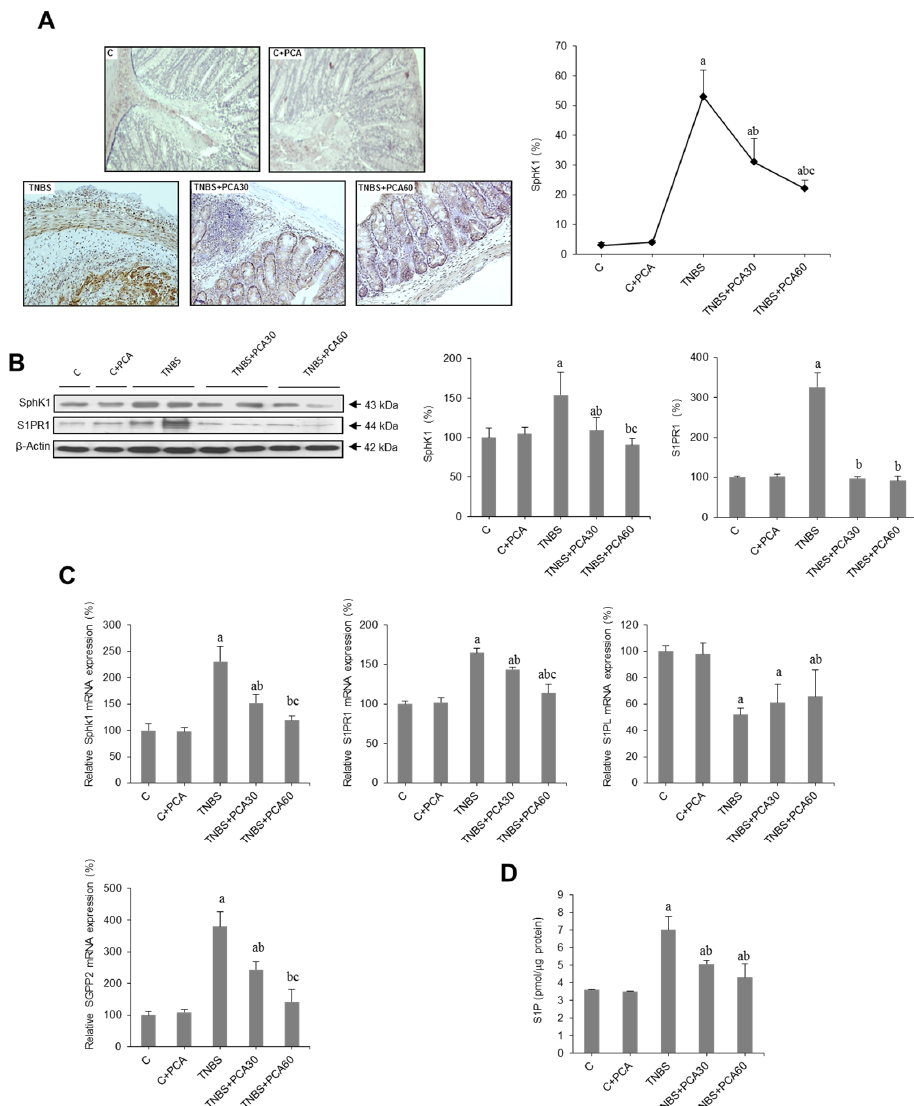
Figure 4. Effect of treatment with protocatechuic acid (PCA) on SphK/S1P signaling pathway ‐ related genes in mice with 2,4,6 ‐ trinitrobenzenesulfonic acid (TNBS) ‐ induced colitis. Representative sections of SphK1 immunohistochemistry in colonic tissues from C, C + PCA, TNBS, TNBS + PCA30 and TNBS + PCA60, and quantification of the positive cells. Image analysis was performed using the ImageJ software v3.91 with ten non ‐ overlapping randomly chosen histological fields. Photographs are taken under magnification ×200 ( A ). Representative blots for SphK1 and S1PR1 protein, and results of densitometric quantification ( B ). mRNA expressions of SphK1, S1PR1, S1PL and SGPP2 genes ( C ), and level of S1P in colon homogenates analyzed by ELISA ( D ). Values are expressed as the means ± SEM of six mice per group. a p < 0.05 vs. C group; b p < 0.05 vs. TNBS group; c p < 0.05 vs TNBS + PCA 30 group. Each assay was performed in triplicate.